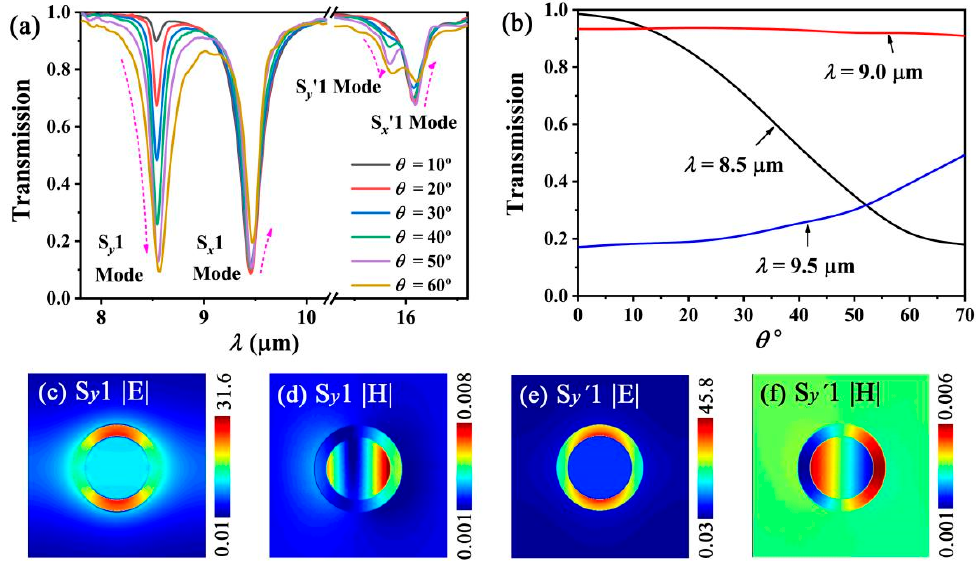
Figure 9. ( a ) Simulated transmission spectra with different incident angular θ for an oblique incident light. ( b ) Transmission values as a function of θ for the different wavelengths of the incident light. ( c – e ) show the | E | distribution of the S y 1 and S y ′ 1 modes, respectively. ( d – f ) show the | H | distribu- tion of the S y 1 and S y ′ 1 modes, respectively.